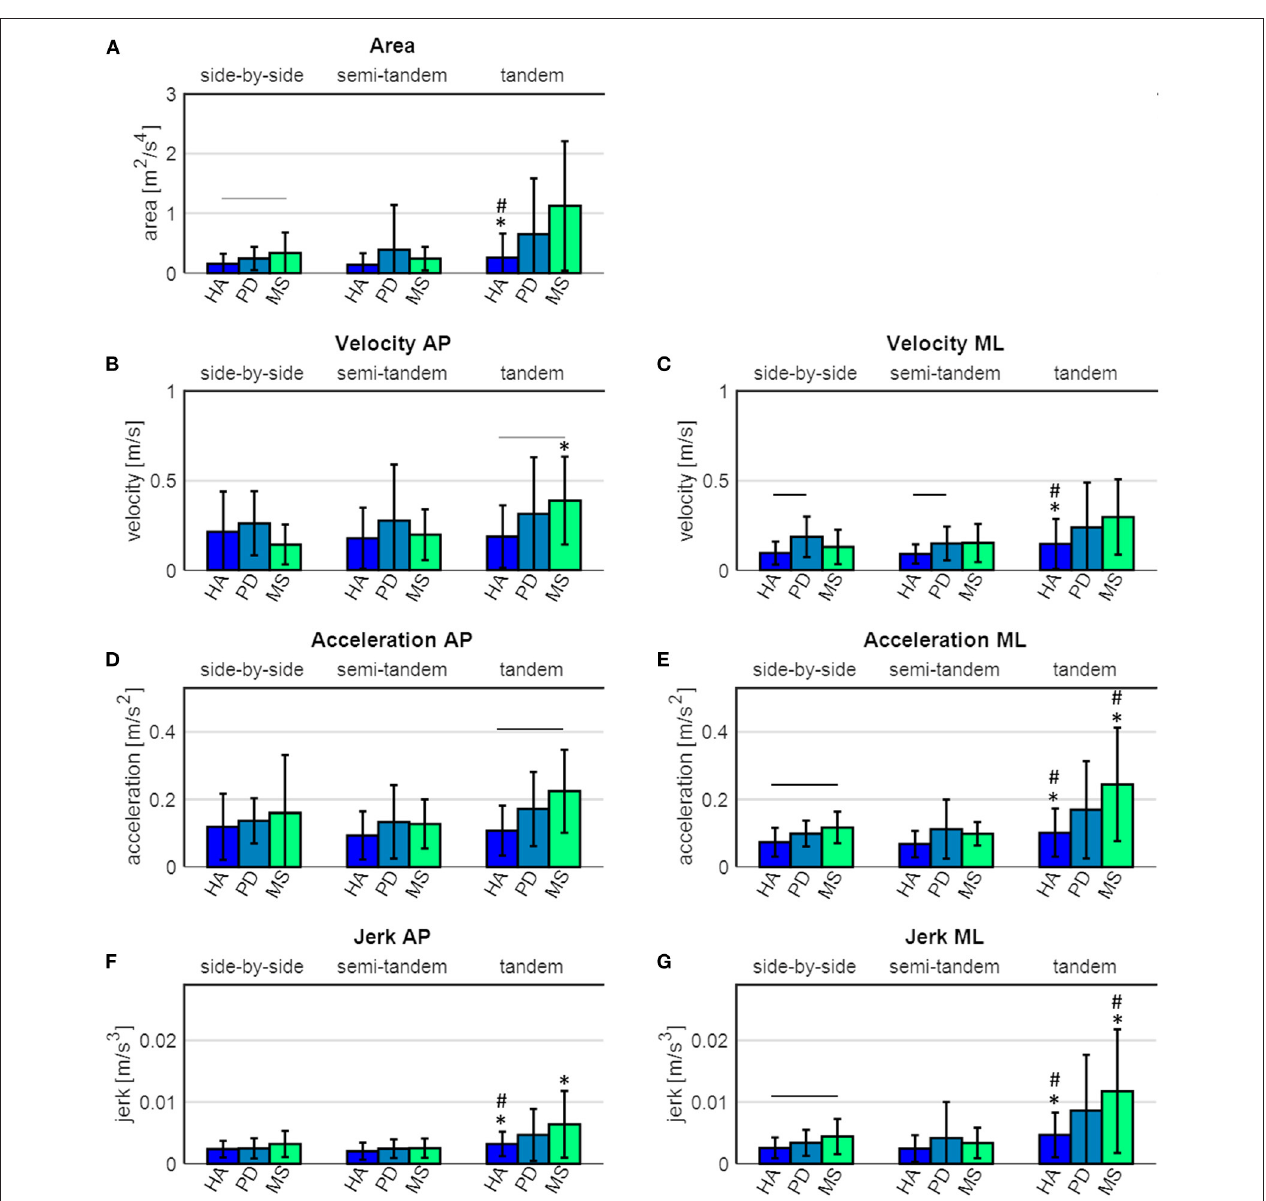
FIGURE 3 | Sway parameters of healthy adults (HA), Parkinson’s disease (PD) and multiple sclerosis (MS) patients. (A) sway area, (B) velocity in antero-posterior (AP) direction, (C) velocity in medio-lateral (ML) direction, (D) acceleration in AP direction, (E) acceleration in ML direction, (F) jerk in AP direction and (G) jerk in ML direction. The black horizontal lines indicate a significant difference between the groups, the grey horizontal lines indicate a tendency toward a difference between the groups. * indicates a significant difference compared to the side-by-side stance, # indicates a significant difference compared to the semi-tandem